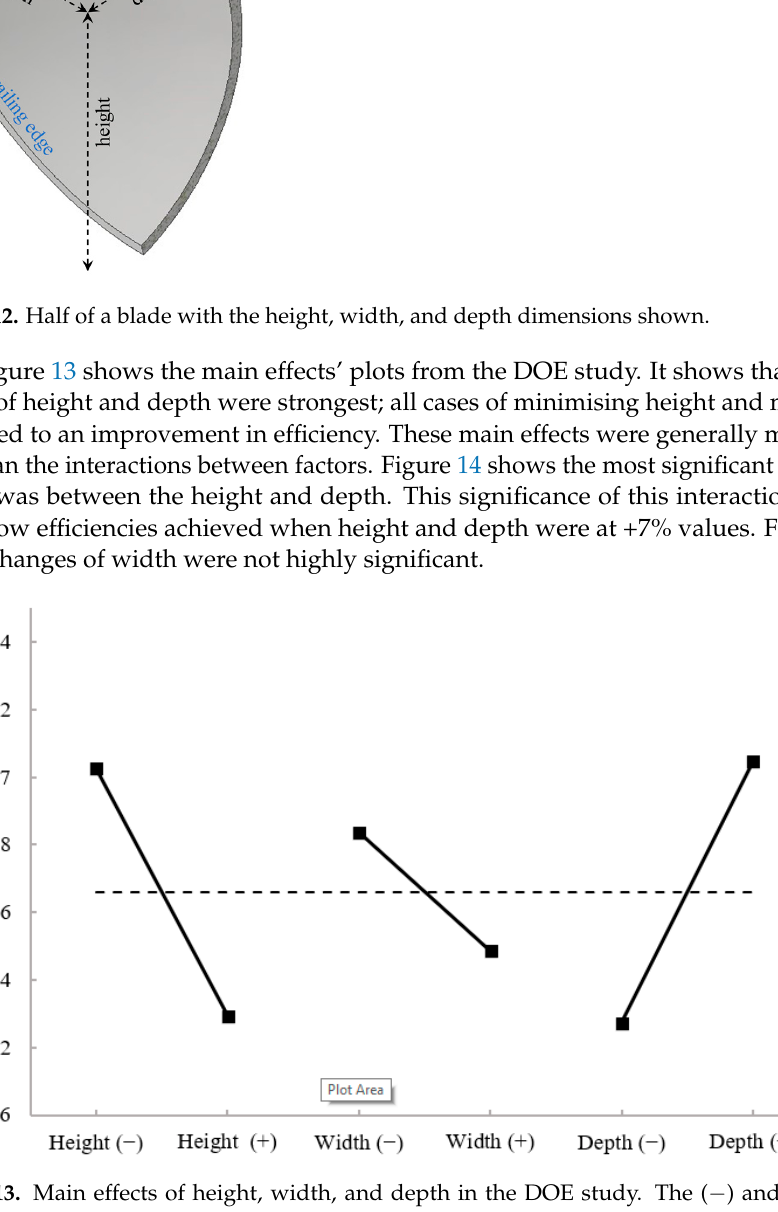
Figure 14. Interaction between width and height in the DOE study. The ( − ) and (+) refer to changes to the original dimension of − 7% and +7%, respectively.